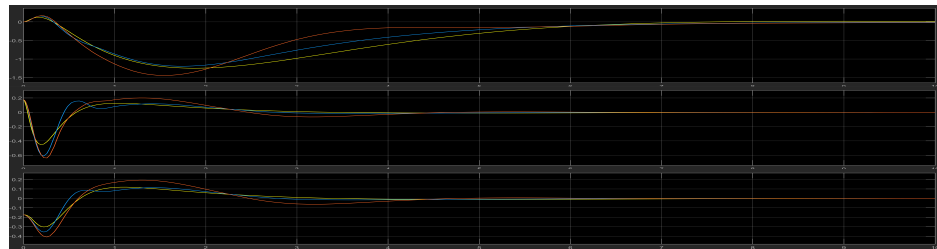
Figure 25. FLC (light blue), LQR (yellow), and modified FLC